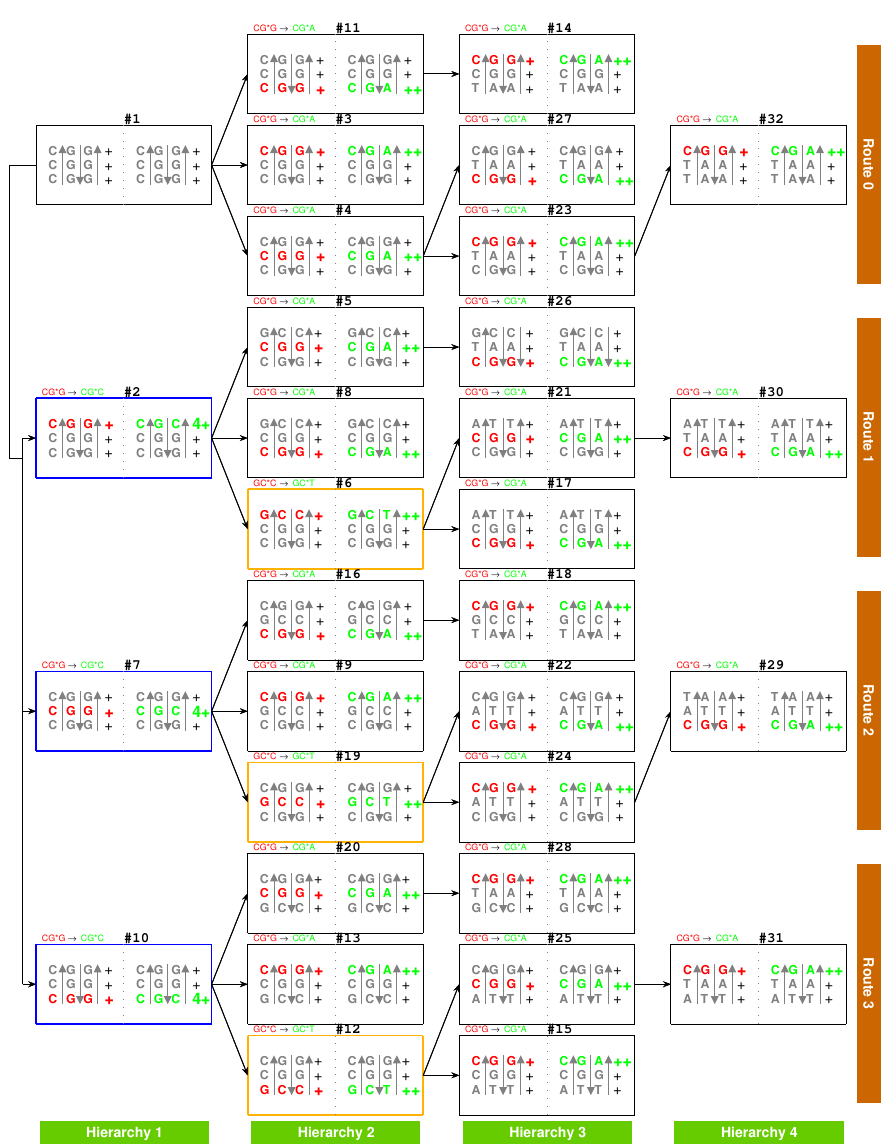
Figure 2. The driving force in the evolution of the genetic code based on the relative stabilities of triplex base pairs. The base substitutions on the roadmap occur when the relative stabilities of triplex base pairs increase. The roadmap is the best result to avoid the unstable triplex base pairs. So, the universal genetic code is a narrow choice by the relative stabilities of triplex base pairs. The relative stability increases from (+) of the triplex base pair CG ∗ G to (4+) of the triplex base pair CG ∗ C at #2, #7, and #10 that initiates Route 1 ∼ 3, respectively. GC ∗ C (+) changes to GC ∗ T (++) at #6, #19, and #12, and CG ∗ G (+) changes to CG ∗ A (++) at other positions on the